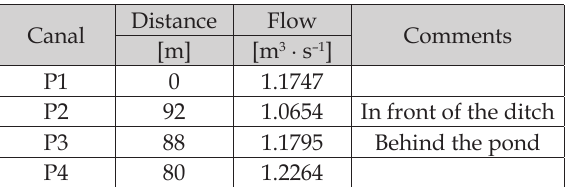
Table 7. results of the water flow rate measurement in the canal of the Moszczenica.